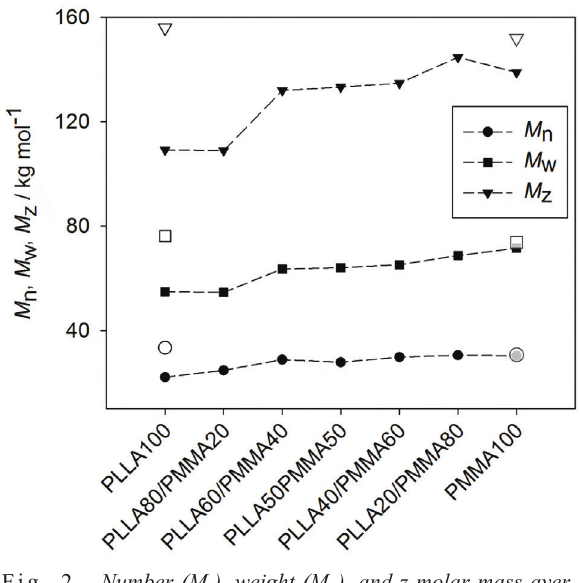
), and z-molar mass aver- w